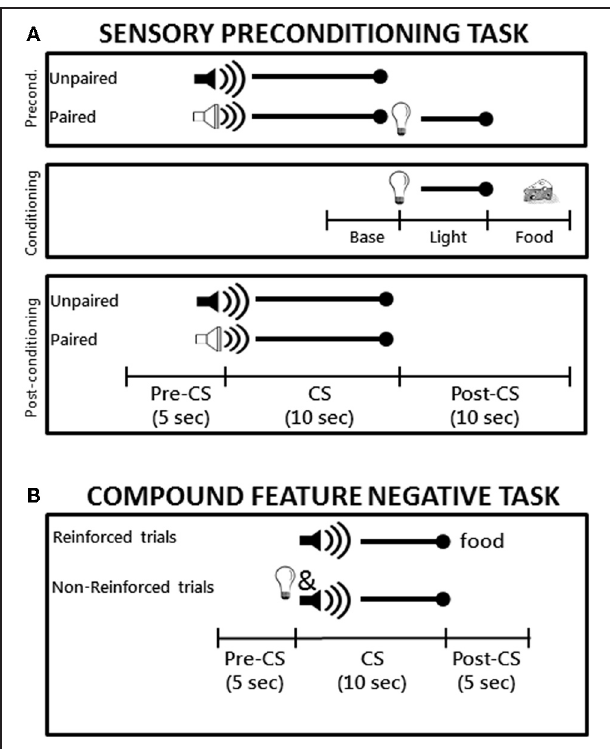
FIGURE 1 | (A) Schematic diagram the sensory preconditioning task used in Experiment 1. The time line and epochs (Preconditioning: Baseline, Light, Food; Post-conditioning: Pre-CS, CS, Post-CS) noted on the bottom refer to the time periods used in the analyses described in the Materials and Methods. (B) Schematic diagram of the compound feature negative discrimination task used in Experiment 2. Rats were tested on a total of 8 daily conditioning